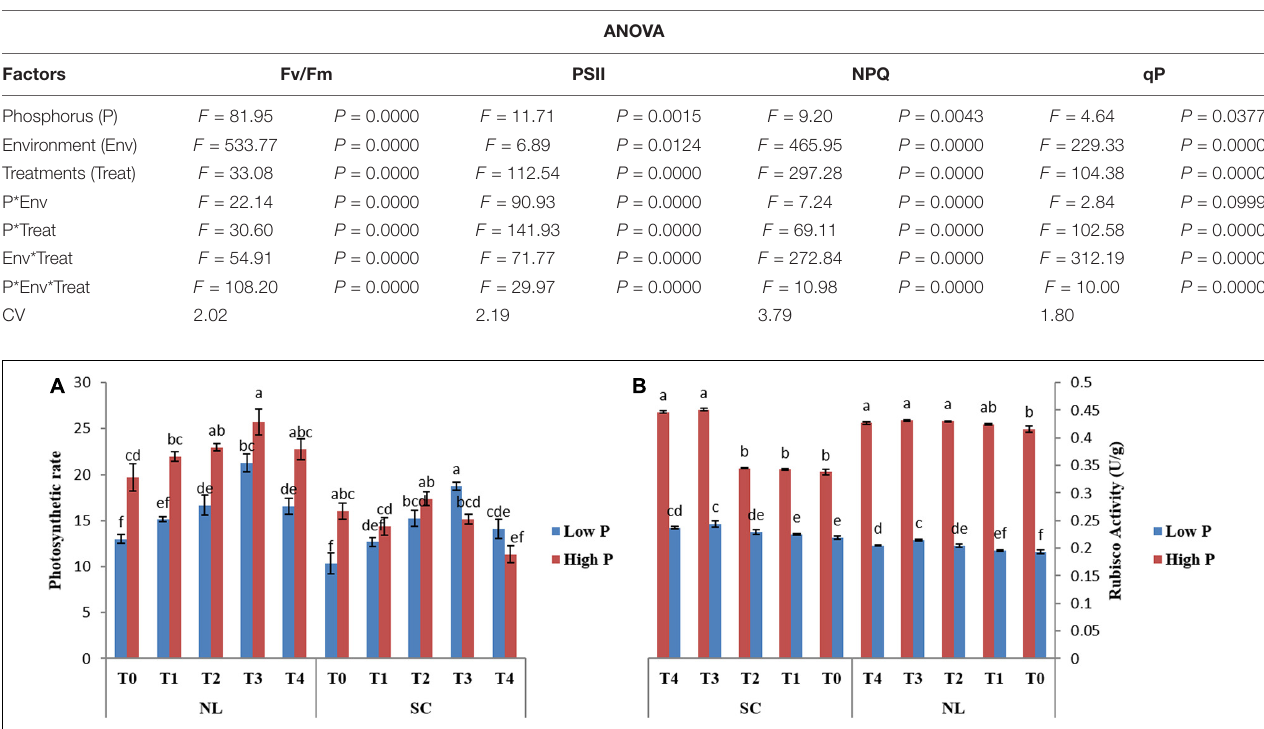
TABLE 2 | Values under ANOVA are the F-test, probabilities ( P value) and coefficient of variation of the sources of variation (LSD, P < 0.05).